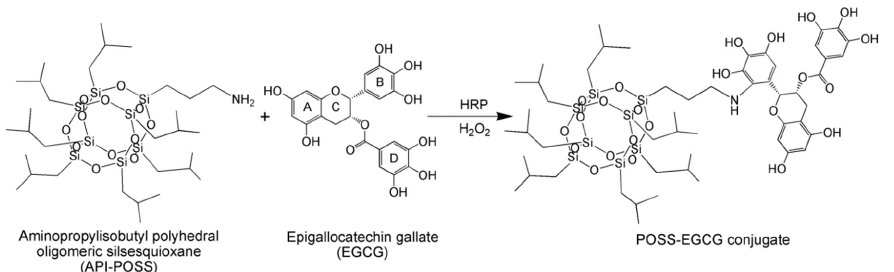
Figure 1. Schematic diagram of enzymatic synthesis of the polyhedral oligomeric silsesquioxane– epigallocatechin gallate (POSS–EGCG) conjugate.